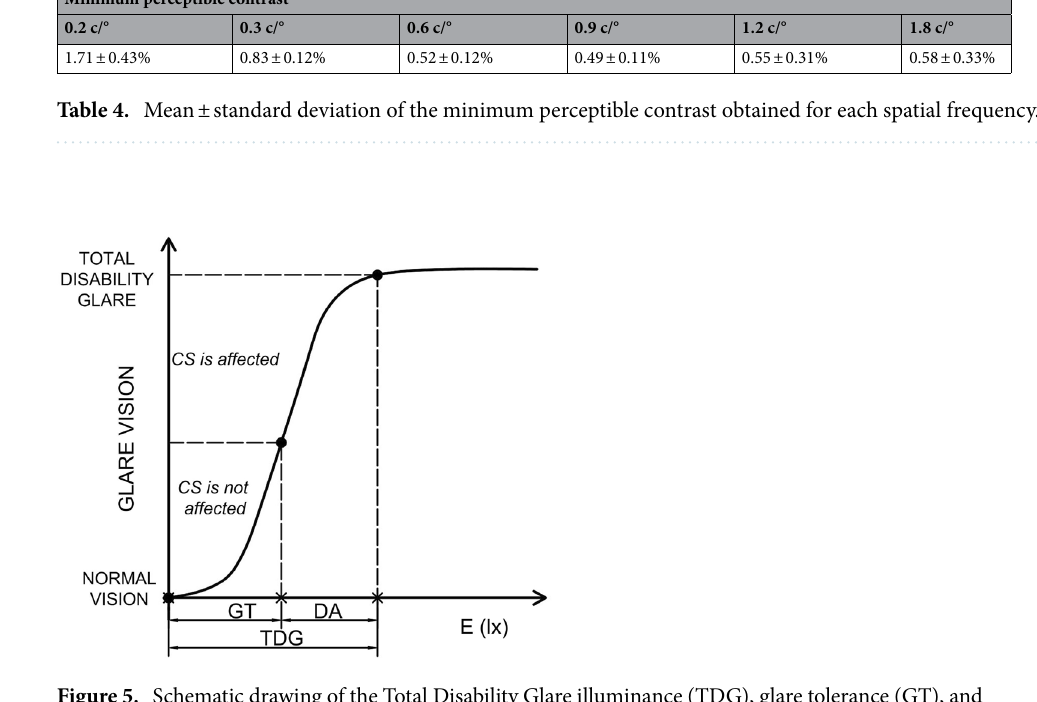
Figure 5. Schematic drawing of the Total Disability Glare illuminance (TDG), glare tolerance (GT), and disability acceptance (DA) parameter. The x-axis represents the illuminance at the pupil plane, and the y-axis represents the stages of glare